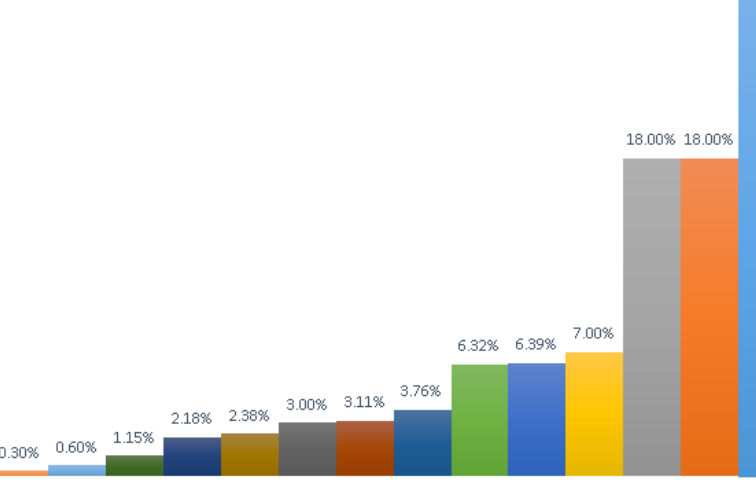
Figure 5. Percentages of attack methods used to deface websites in 2010–2016 (Source: Zone-H Archive)